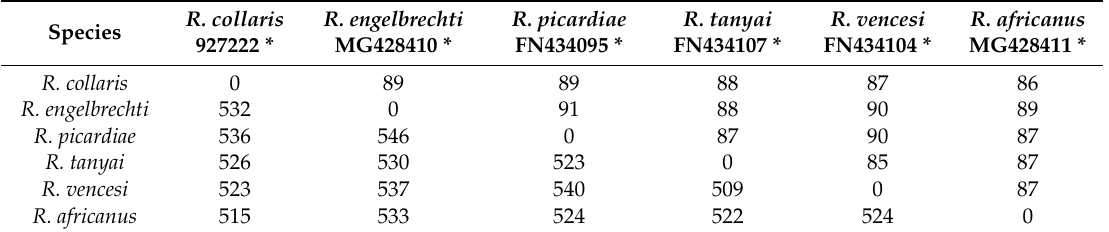
Table 4. Percentage (upper triangle) and number (lower triangle) of identical sites based on the 596-bp-long alignment of partial sequences of COI gene of African Rhabdias species. R. Species